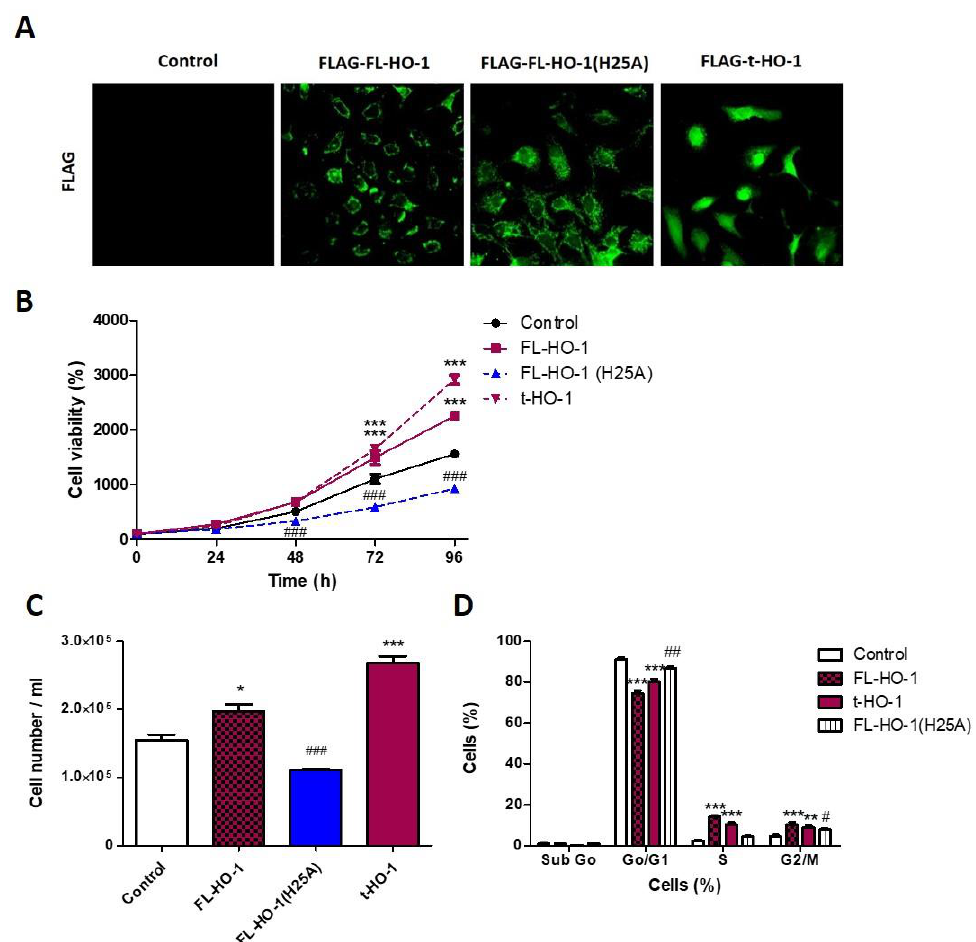
Figure 6. Subcellular localization and loss of enzymatic activity of HO-1 affects HN13 cell viability. HN13 cells were transfected with FLAG vectors bearing FL-HO-1, FL-HO-1 (H25A) or t-HO-1 constructs. ( A ) Representative images of direct immunofluorescence for FLAG showing differential subcellular location of HO-1 expression among stable transfectants HN13 cells. ( B ) Cell viability of the stably transfected HN13 cells was evaluated at 24 through 96 h. ( C ) Cell number of the stably transfected HN13 cells was counted at 72 h. ( D ) Cell cycle progression of the stably transfected HN13 cells was evaluated at 96 h. The results are expressed as cell viability percentage = (selected time group × 100/time 0 h group), being selected time 24 h to 96 h. * p < 0.05, ** p < 0.01 and *** p < 0.001 with respect to the control. # p < 0.05, ## p < 0.01 and ### p < 0.001 respect to FL-HO-1 (H25A).